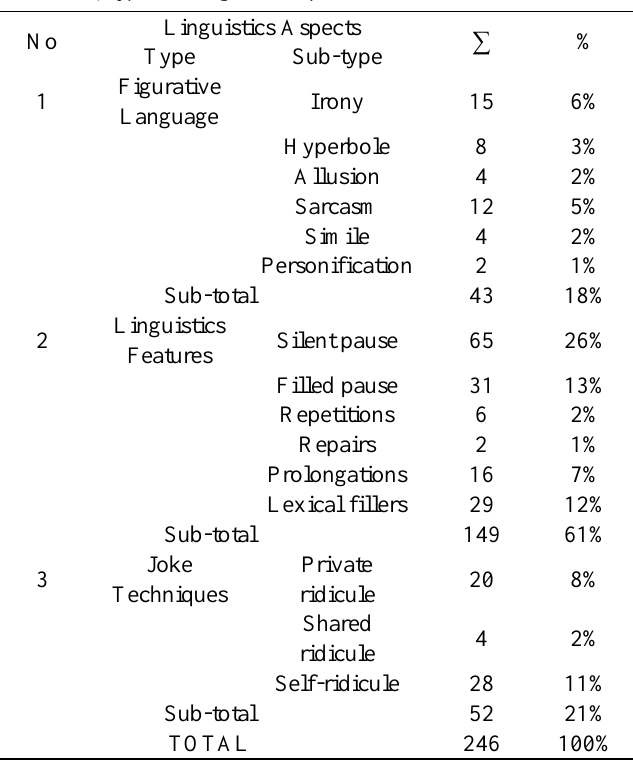
TABLE 1 | Types of Linguistic